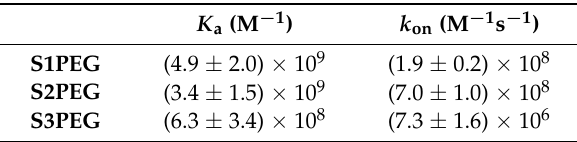
Figure 6. ( left ) Absorbance and ( right ) emission spectra (ex: 750 nm) of ICG , S3PEG , M2 ⊃ S3PEG with concentration adjusted to give identical absorbance values (0.08) at 750 nm in H 2 O.